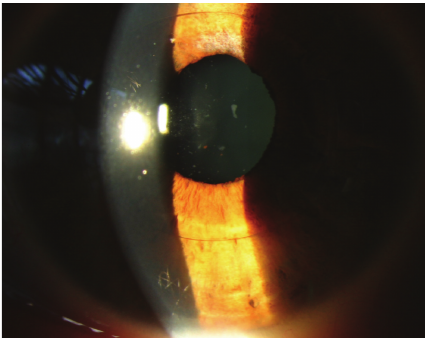
Figure 1: Foldable iris claw fixated anterior chamber IOL made from hydrophobic polysiloxane 2 months after implantation show- ing typical inflammatory deposits despite continuous local fluo- rometholone t.i.d. medication.